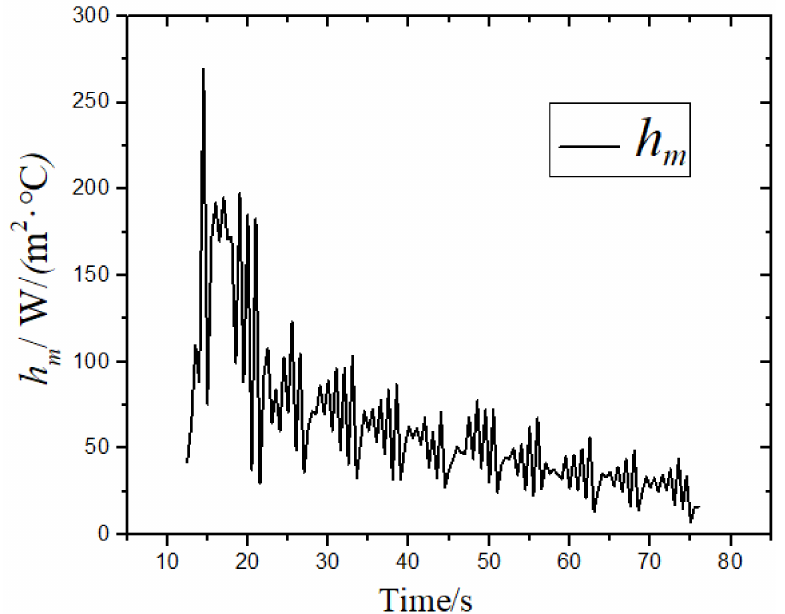
Figure 9. The change of the average surface integrated convection heat transfer coefficient with